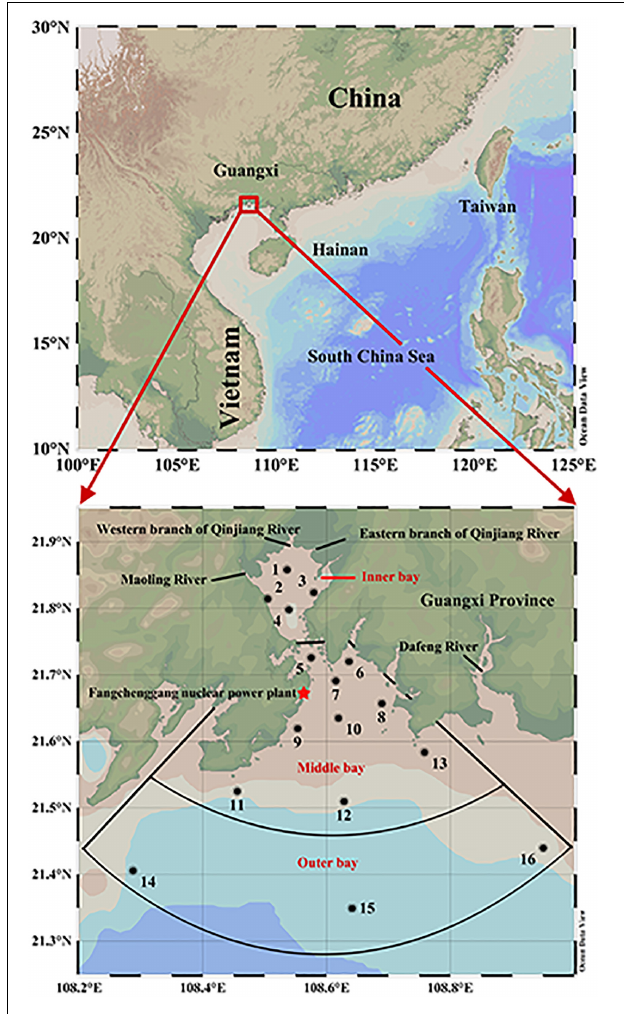
FIGURE 1 | Sampling sites in the Qinzhou